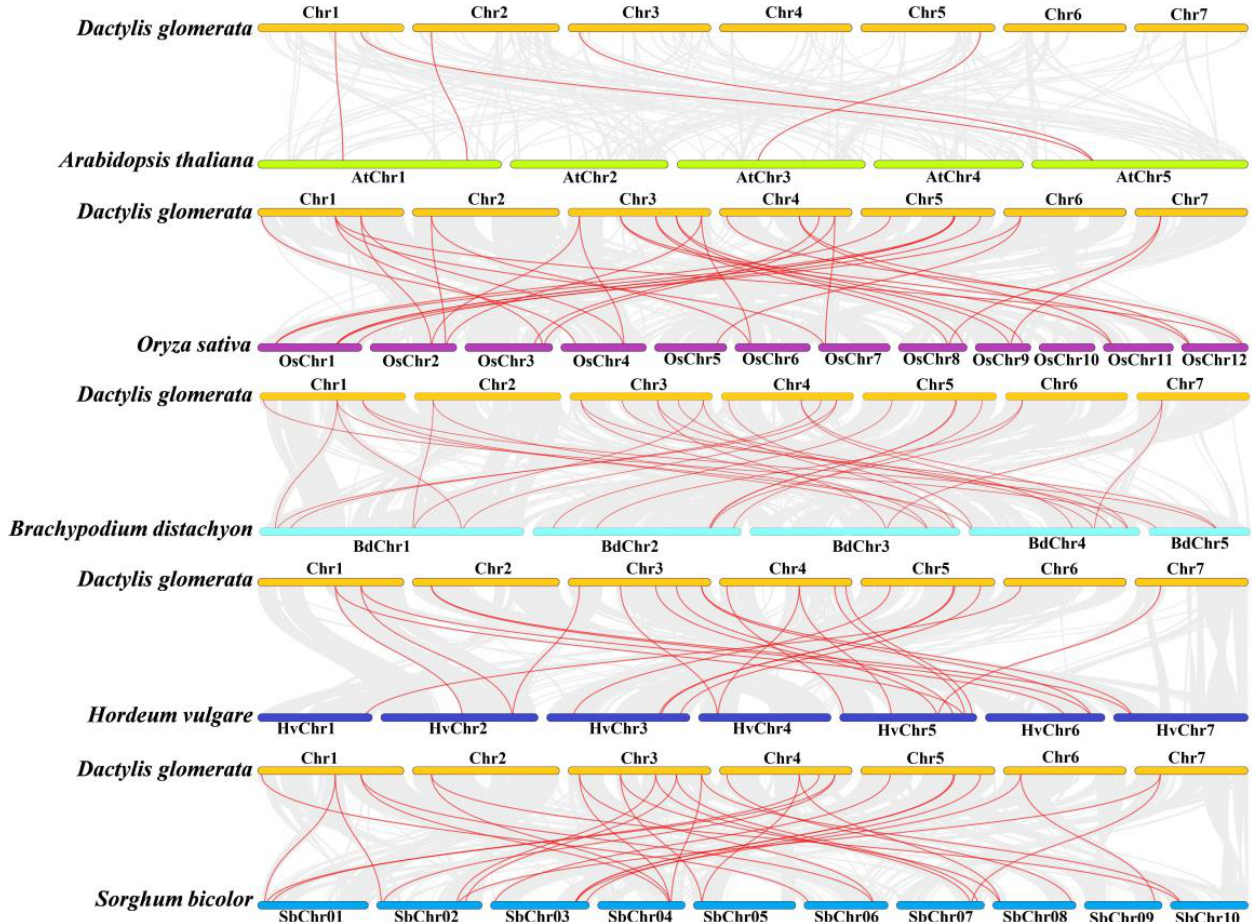
Figure 6. Collinearity of the TCP genes between D glomerata and A thaliana , O sativa, S bicolor, H vulgare, and B distachyon . The red lines in the background represent the TCP gene pairs. The cis-elements in promoters are essential for transcriptional regulation and gene function analysis. Therefore, to provide further insight into the gene functions and regu- lation mechanisms of DgTCP genes, 93 cis-elements possibly involved in phytohormone response, plant growth and development, and stress response were identified to unravel the functions and regulatory mechanisms of DgTCP genes (Table S9). The TATA- and CAAT-box had the most cis-elements among the 22 DgTCPs (Table S9). Interestingly, the AACA-motif, MBSI, HD-Zip 1, circadian, and AuxRR-core only existed in 1 of 22 DgTCPs (Figure 7), indicating their likely unique roles in those genes and, by extension, the regula- tory pathways and processes involving those